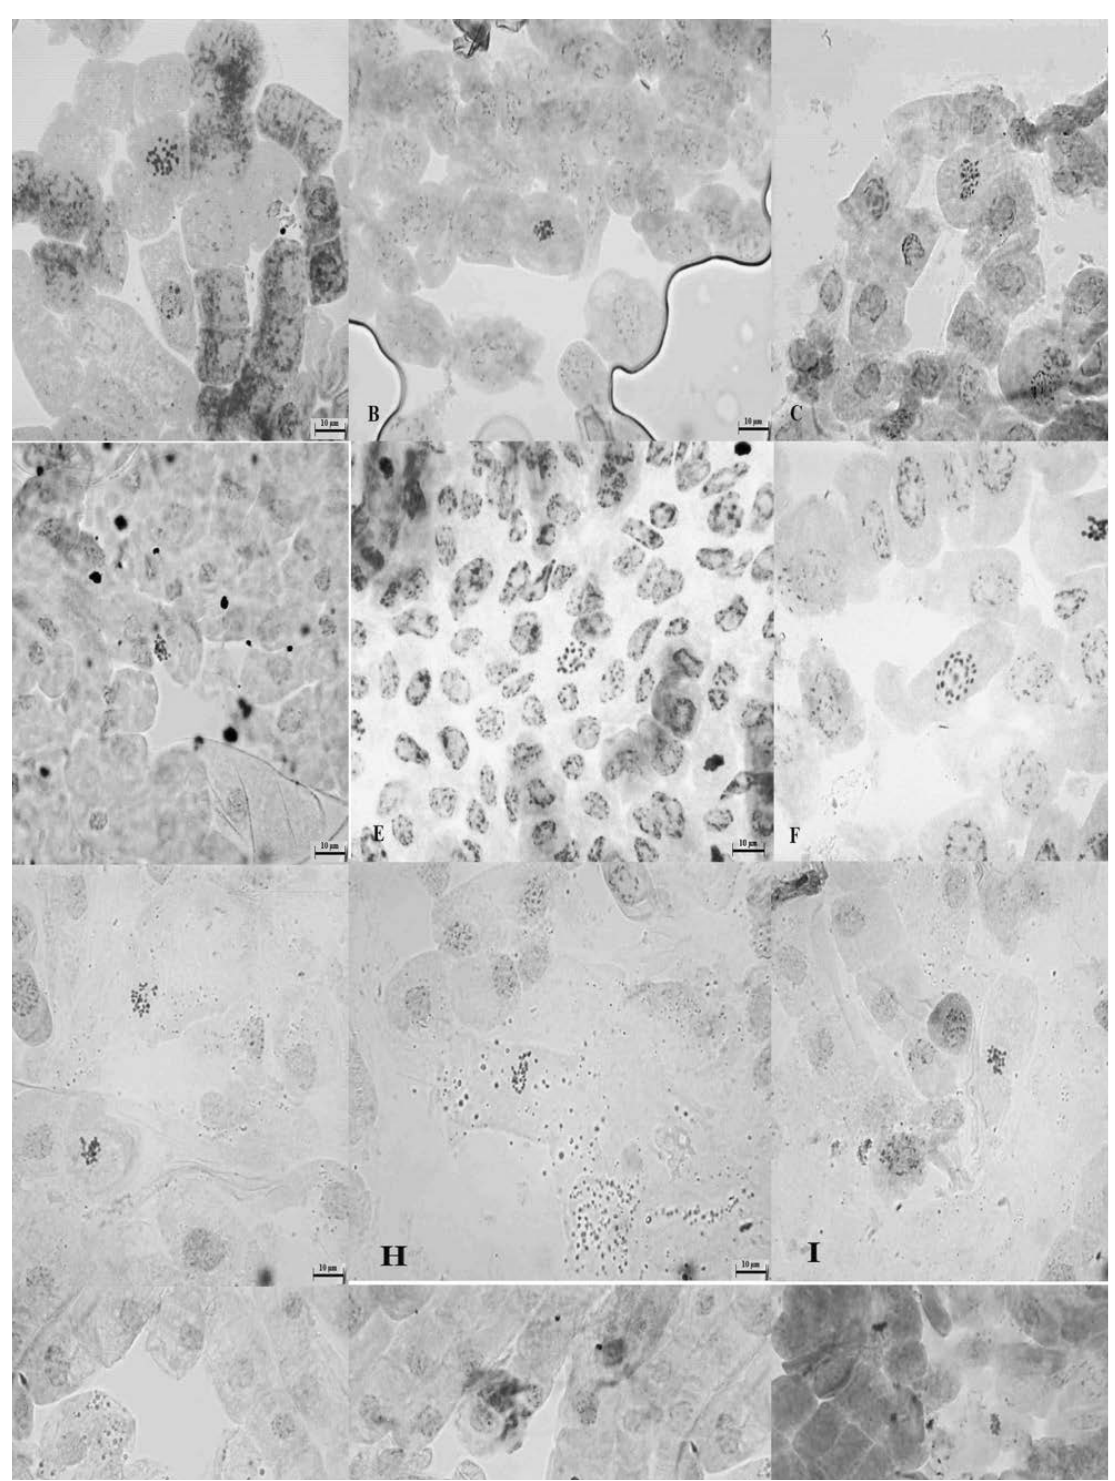
Figure 2A-L. Somatic metaphase chromosomes of hybrids and their parents: A) O. × adae (TD4518); B) O . ayliniae (TD4516); C) O . sipyl- eum (TD4517); D) O . × haradjanii (TD4335); E) O . syriacum subsp. bevanii (TD4336); F) O. laevigatum (TD4497); G) O . × intermedium (TD4726); H) O . onites (TD4725); I) O . sipyleum (TD4727); J) O. × sevcaniae (TD4508); K) O . vogelii (TD4509); L) O . vulgare subsp. hir- tum (TD4507). Scale bar: 10